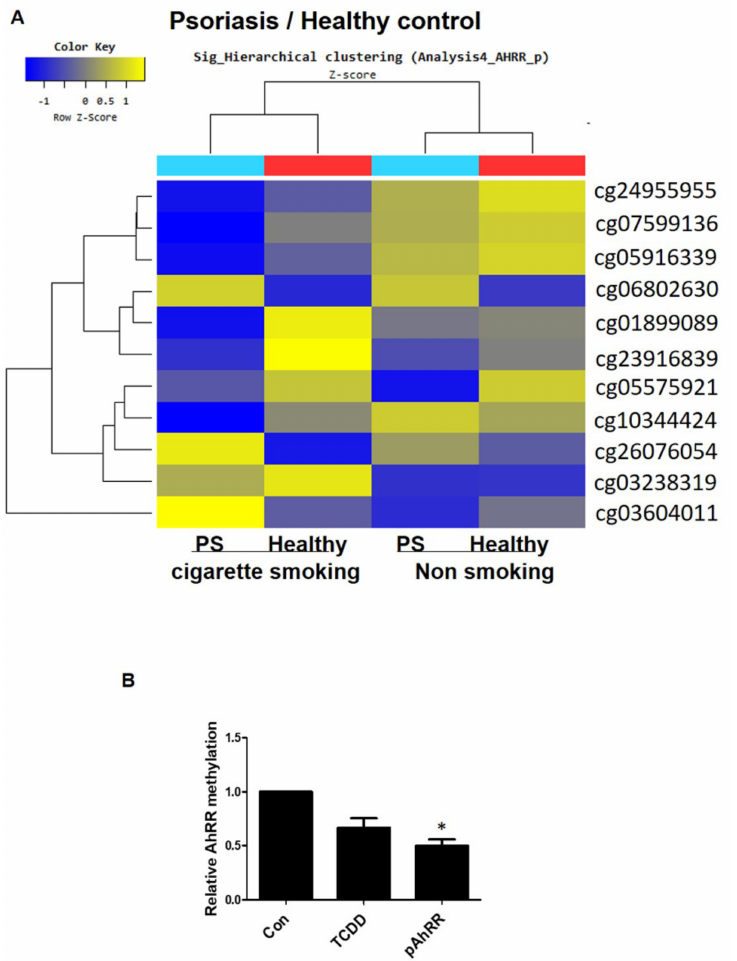
Figure 2. Effect of hypomethylation in PBMC of psoriasis and in HaCaT cells. ( A ) Data corresponding to the AhRR gene of healthy and psoriasis PBMC samples are displayed as a color-coded gene-by- sample heatmap, with rows (AhRR genes) and columns (control and psoriasis patients or smoking and non-smoker groups) sorted by hierarchical clustering. Dark blue is hypomethyl and light blue is less hypomethylation. Dark yellow is hypermethylation and light yellow is less hypermethylation. ( B ) HaCaT cells were transfected with pAhRR (0.3 µ g) for 24 h and treated with TCDD (500 nM) for 24 h. AhRR methylation was examined by methylation-specific PCR (MSP). Values are means ± SEM. All experiments were performed in at least three independent experiments. * p < 0.05 vs.